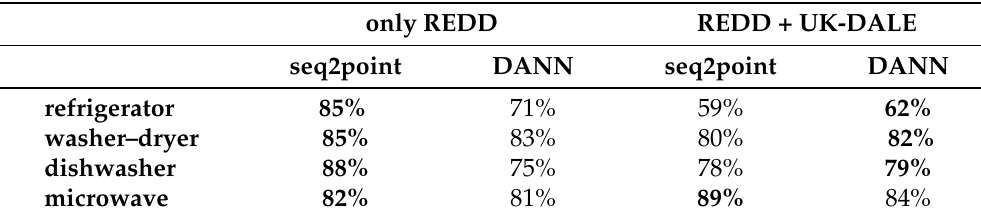
Table 9. Comparison of the obtained F1